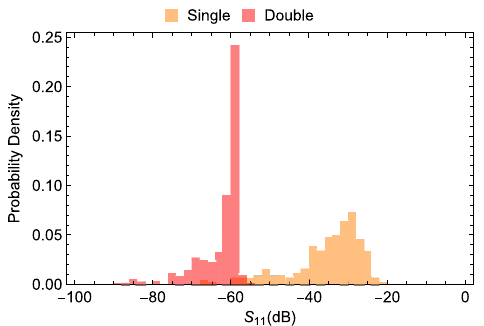
FIG. 22. Single vs double choke reflection tolerances, obtained by varying 5 geometrical parameters for the single choke and 6 geometrical parameters for the double choke uniformly (cid:2) 5 μ m.